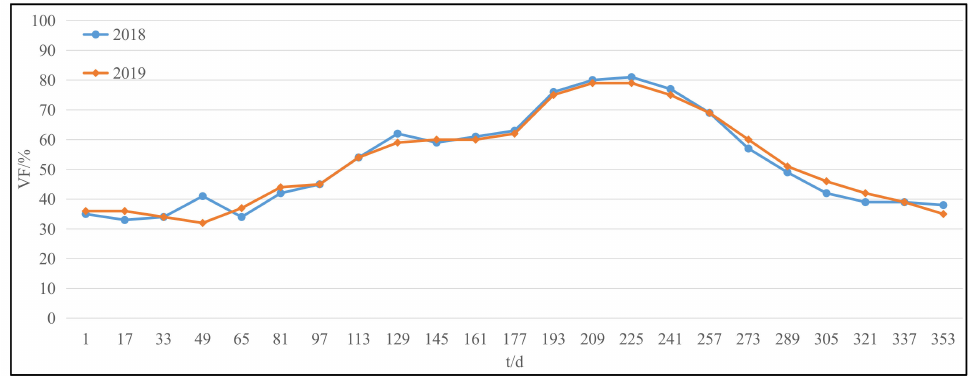
Figure 10. Seasonal variation of the fractional vegetation cover (FVC) of the Beijing-Tianjin-Hebei region in 2018 and 2019.